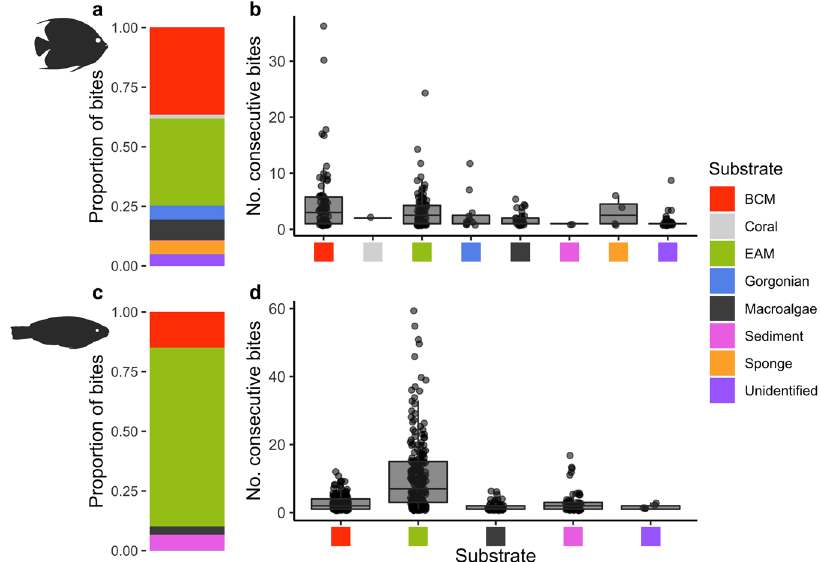
Figure 2. Composition of bites and consecutive bites per substrate for P . paru and S . iseri . ( a ) Proportion of total bites for each substrate for P . paru (mean ± SE): BCM (benthic cyanobacterial mat) 36.7% ± 5.8%; Coral 1.56% ± 1.56%; EAM (epilithic algal matrix) 36.5% ± 4.67%; Gorgonian 5.93% ± 2.73%; Fleshy Macroalgae 8.61% ± 1.93%; Sediment 0.24% ± 0.17%; Sponge 5.57% ± 4.67%; Unidentified 5.0% ± 1.52%. ( b ) Boxplots showing median and spread of consecutive bites for each substrate taken by P . paru individuals. Circles denote individual counts. ( c ) Proportion of total bites for each substrate for S . iseri (mean ± SE): BCM 15.0% ± 1.53%; EAM 74.8% ± 3.01%; Fleshy Macroalgae 3.47% ± 0.75%; Sediment 6.44% ± 1.65%; Unidentified 0.28% ± 0.15%. ( d ) Boxplots showing median and spread of consecutive bites for each substrate taken by S . iseri individuals. Circles denote individual